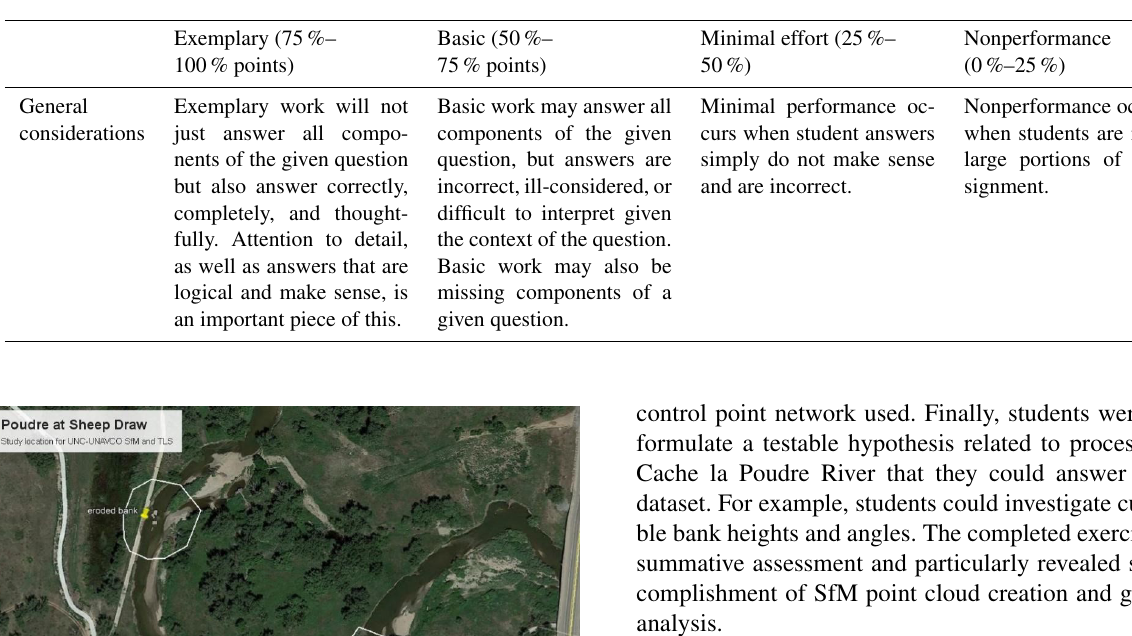
Table 2. Example rubric showing percentage scoring used to assess course activities.